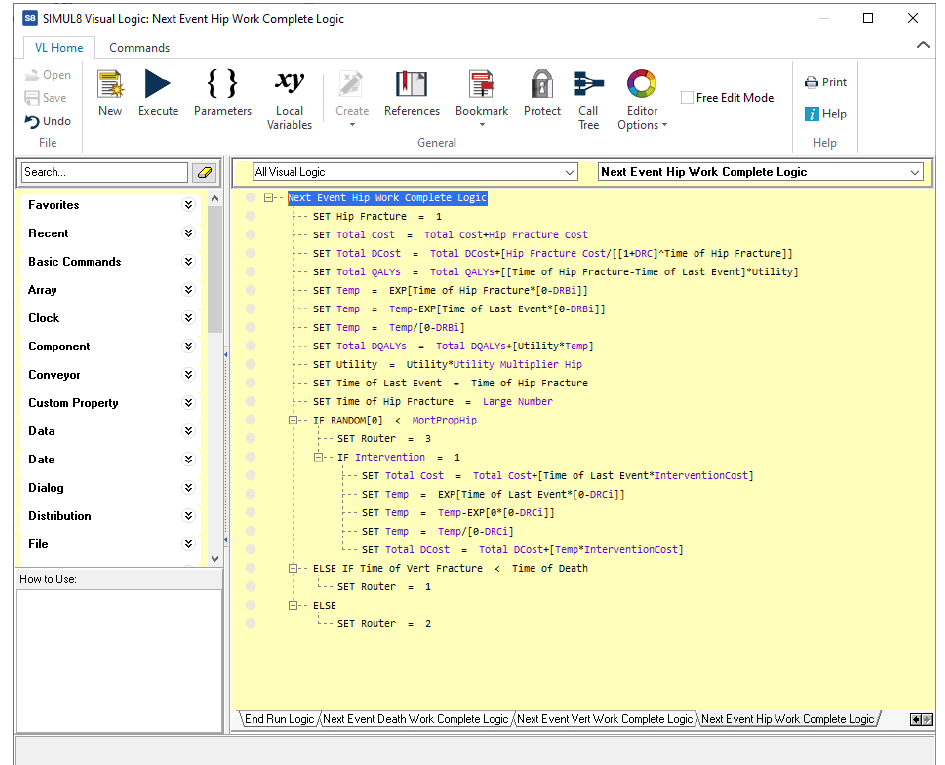
Figure A5. Code for the ‘Hip fracture’ event in for the osteoporosis model in Simul8.